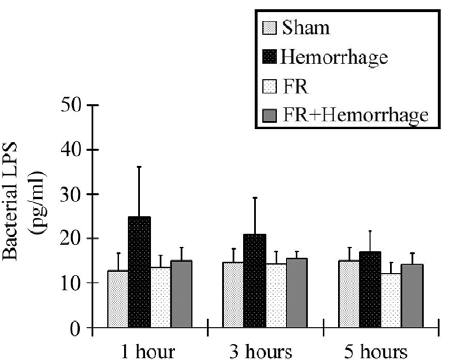
Figure 3. Bacterial LPS concentration in the portal vein. There were no significant increases in the portal LPS concentration in any of the groups throughout the experimental period. Data are shown as mean 6 SE. n=5/groups.